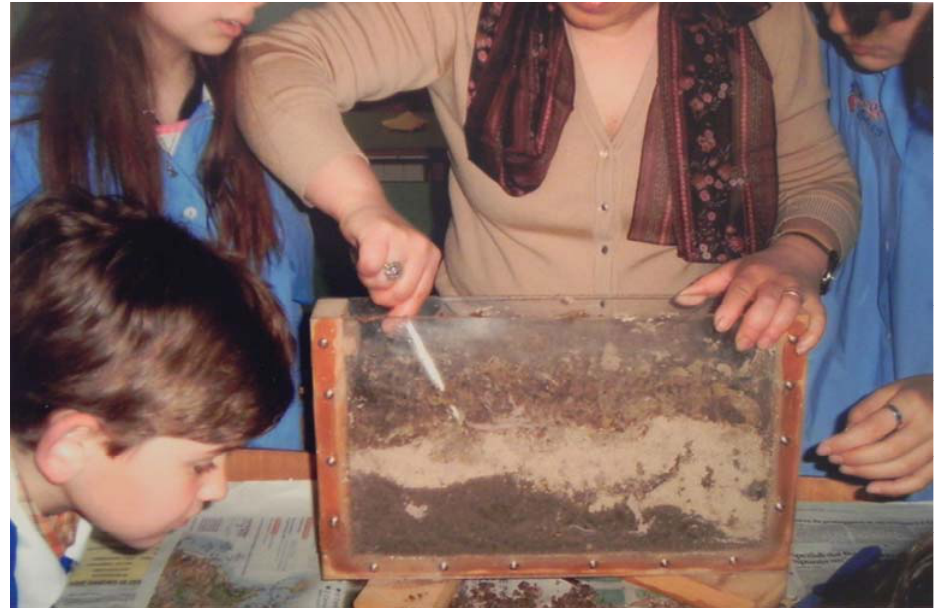
Figure 2. The earthworm farm at the San Francesco Primary School in Santa Vittoria in Matenano, Fermo; courtesy of Silvana